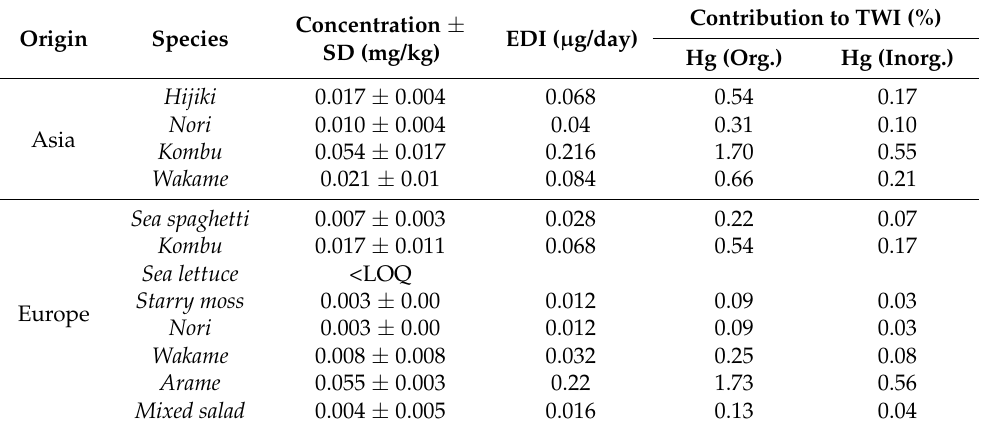
Table 6. Mercury concentrations, estimated intake (EDI), and percentage contribution to the guideline value of the analyzed algae.